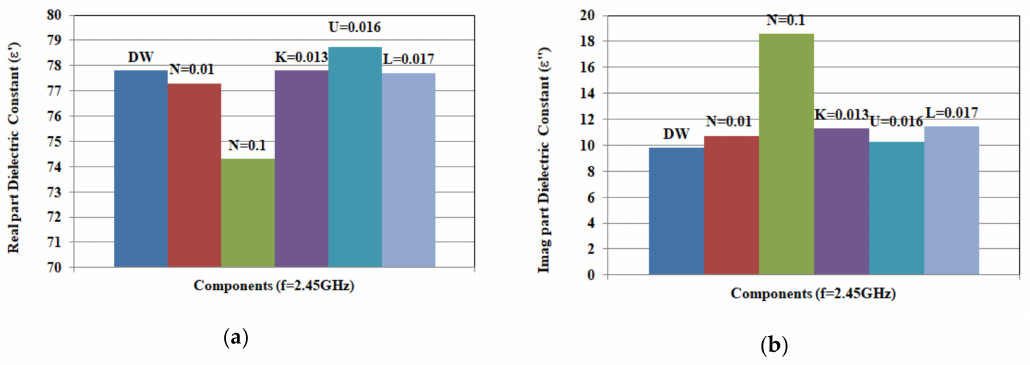
Figure 10. Measured complex permittivity: ( a ) real part ( ε ’) and ( b ) imaginary part at 2.45 GHz for aqueous solutions of single component (N = 0.01, 0.1 mol, K = 0.013 mol, L = 0.017 mol, and U = 0.016 mol). DW is distilled